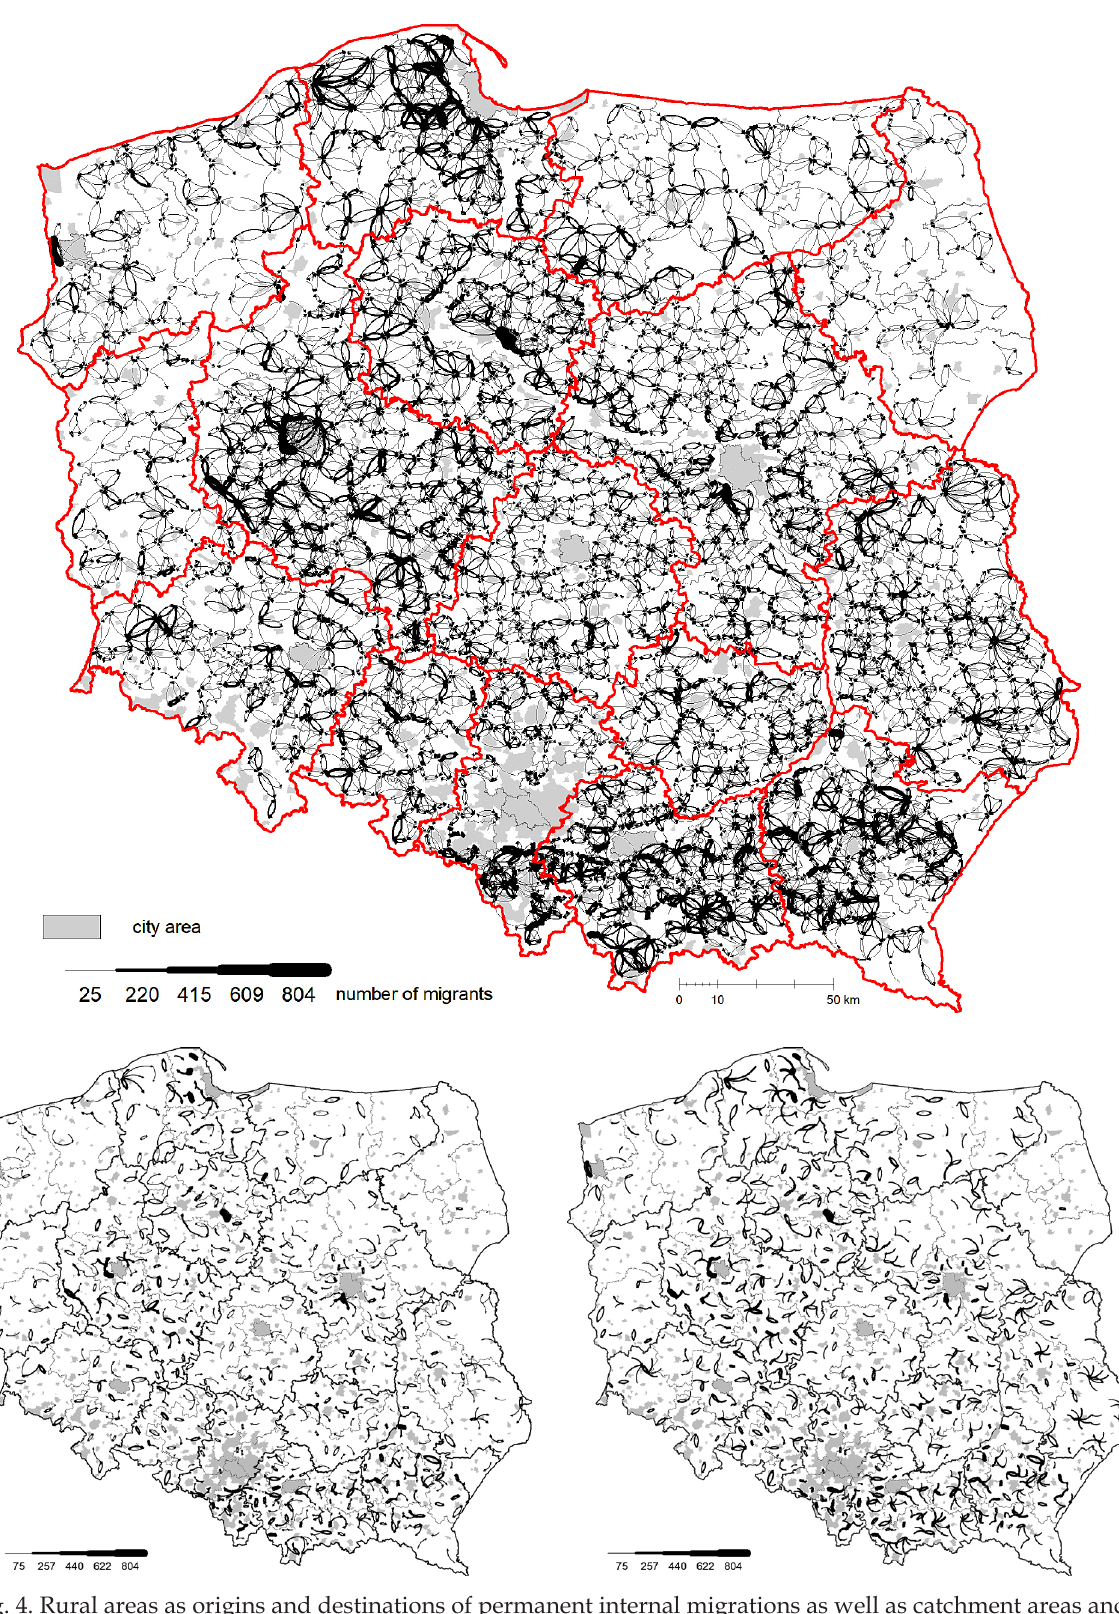
Fig. 4. Rural areas as origins and destinations of permanent internal migrations as well as catchment areas and areas of migratory attractiveness (linear